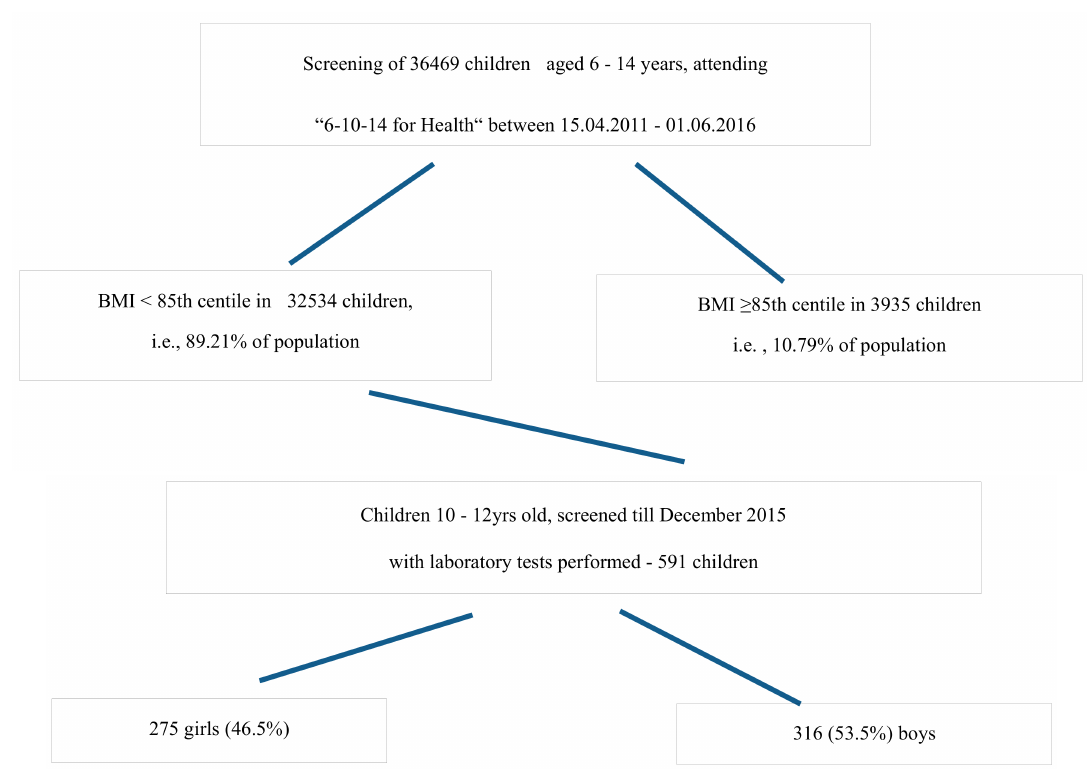
Figure 1. Patient screening and qualification for the study-study